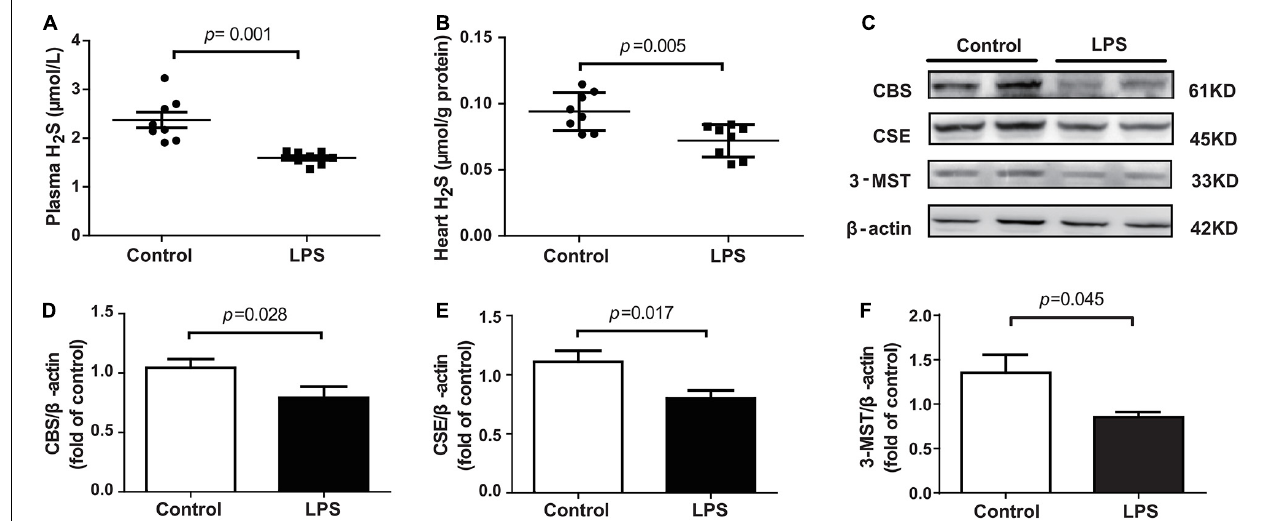
FIGURE 2 | LPS decreased plasma and heart tissues levels of H 2 S in LPS-induced myocardial dysfunction mice: (A) H 2 S levels in the plasma. (B) H 2 S levels in the heart tissues. (C–F) Representative Western blots and quantification of CBS, CSE, and 3-MST protein expression in heart tissues. β -actin was used as the internal control. n = 8 in every group. Results are means ± SEM. p < 0.05 was considered significant.